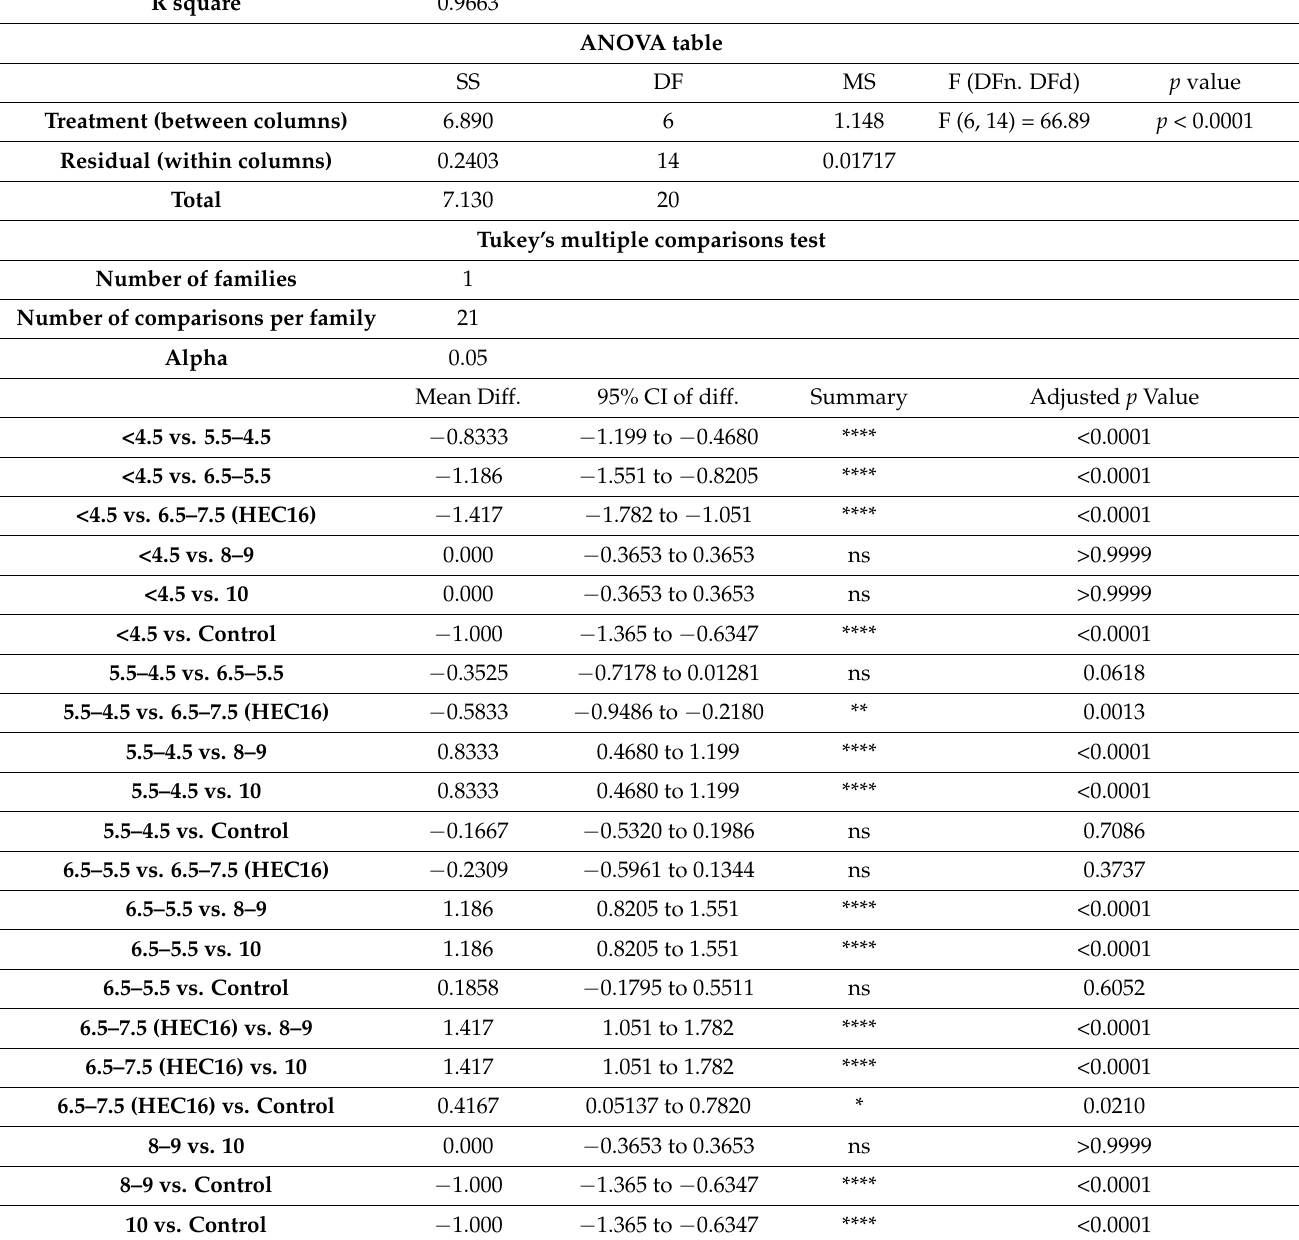
Table A7. One-way ANOVA analysis between different sorbitol concentrations and Tukey’s